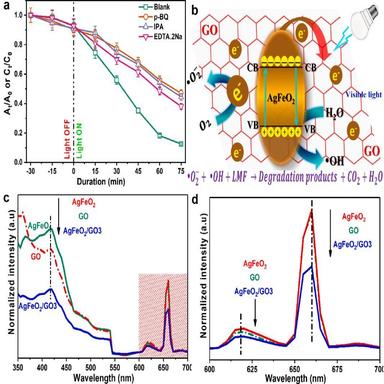
(a) Investigation on active radical responsible for LMF degradation by adding p-BQ, IPA, and EDTA.2Na as superoxide, hydroxyl, and holes scavengers, (b) schematic illustrating the possible interaction of AgFeO2/GO3 aiding LMF degradation, (c), and (d) PL spectra of AgFeO2, GO and AgFeO2/GO3.